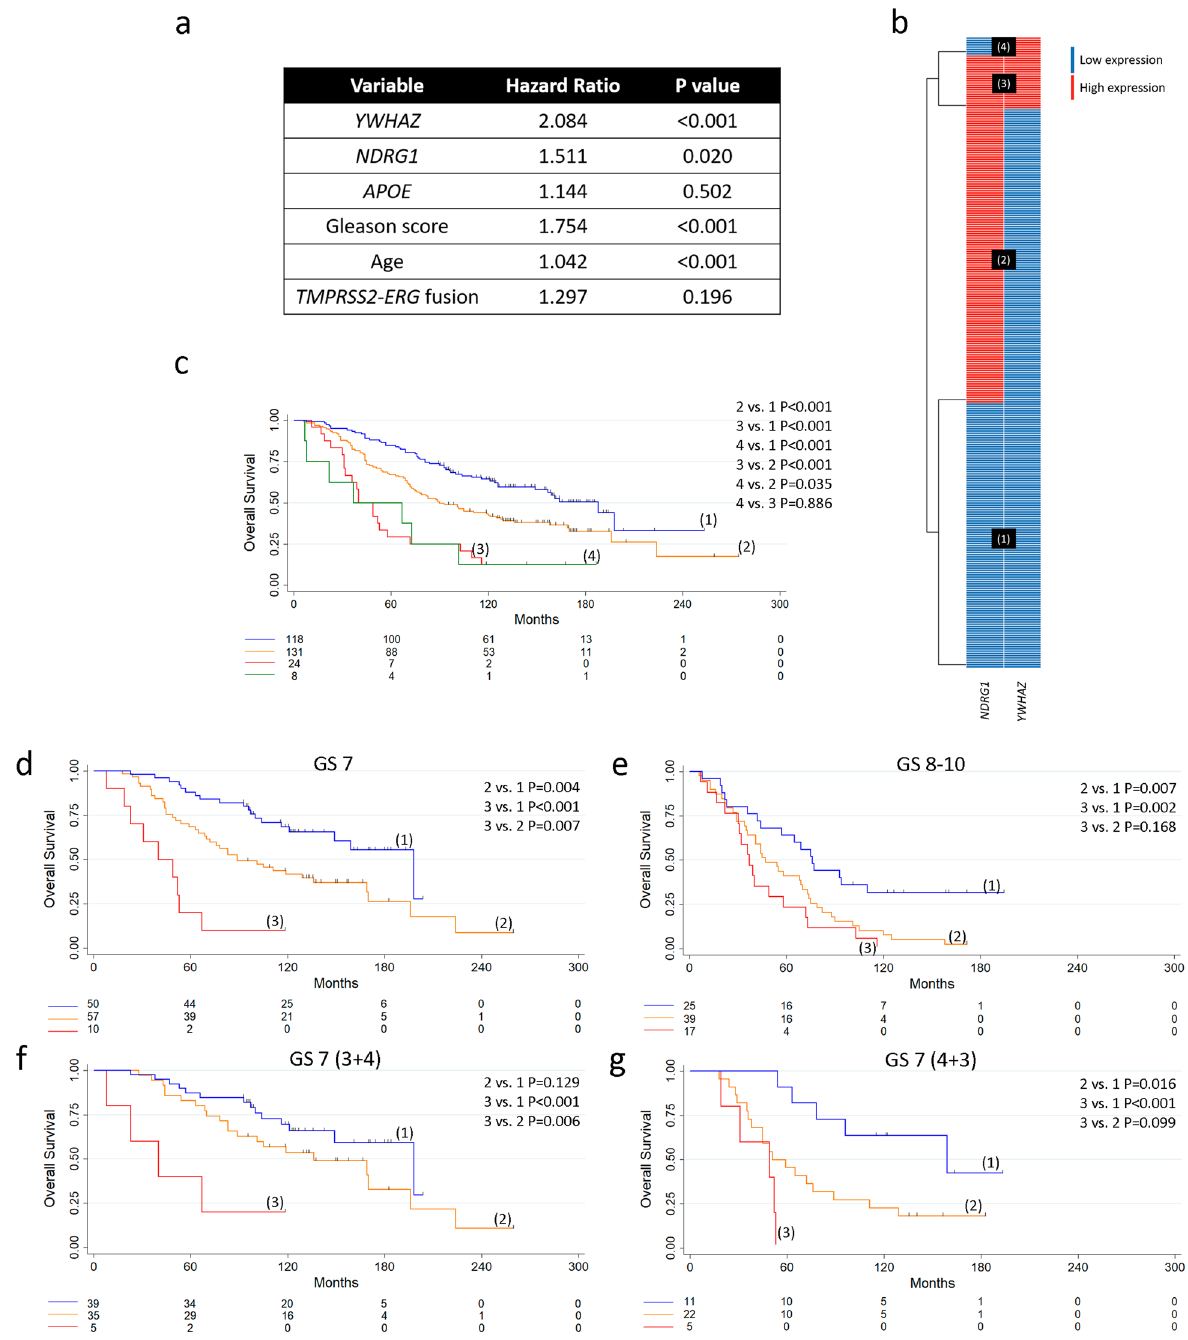
Fig. 4 YWHAZ and NDRG1 as risk strati fi cation genes in PCa patients naive of treatment ( Sboner data set, GSE16560, n = 281). a Multivariable analyses based on gene expression of YWHAZ , NDRG1 , APOE , GS, age and TMPRSS2-ERG fusion for patients with PCa. P = Cox proportional hazard model P -value. b Heatmap depicting low (blue) or high (red) NDRG1 and YWHAZ gene expression for patients with PCa. Patient subgroups are presented in black boxes. c – g OS of patients with low YWHAZ and NDRG1 gene expression (1), high NDRG1 gene expression (2), high YWHAZ gene expression (4), and high YWHAZ and NDRG1 gene expression (3). Kaplan – Meier curves for OS for PCa patients segregated based on gene expression levels for YWHAZ and NDRG1 ( c ), gene expression levels for YWHAZ and NDRG1 for GS 7 ( d ) and GS 8 – 10 ( e ), and gene expression levels for YWHAZ and NDRG1 for GS 7 (3 + 4) ( f ) and GS 7 (4 + 3) ( g ). GS = Gleason score. All comparisons consider low expression patients as the reference group. P = pairwise log-rank P- values. Statistical signi fi cance was set at P ≤ we had to prioritize tissue for LC ESI – MS/MS. Of note, the Sboner data set (GSE16560) included TURP and adenoma enu- cleation specimens, which might introduce short overall survival bias.